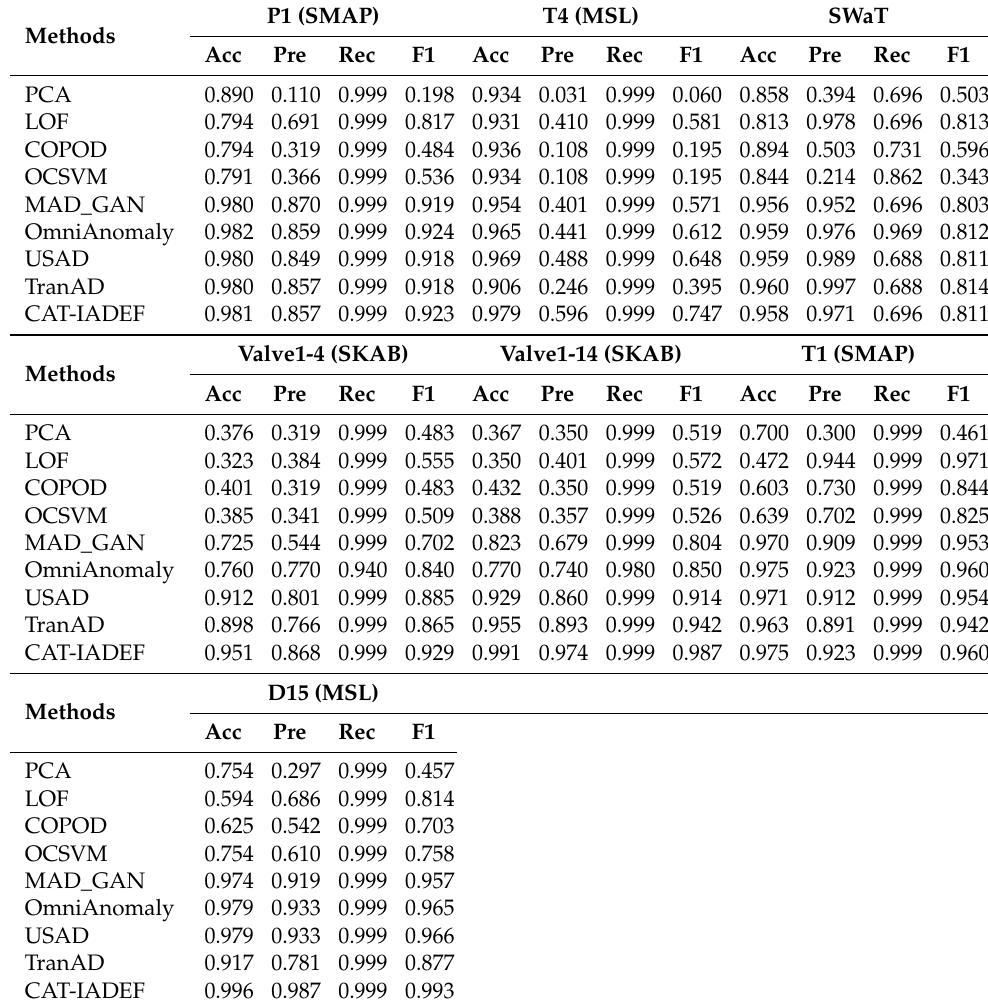
Table 2. Performance comparison of CAT-IADEF and other methods on the subsets of data